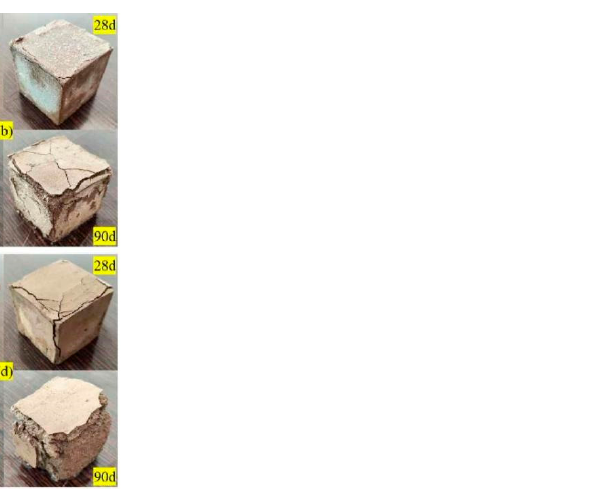
Figure 4. The UCS of SF-GSSS before sulfate a tt ack.